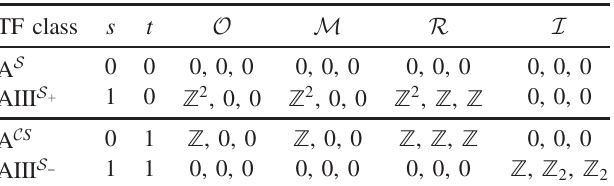
TABLE X. Boundary classification of third-order phases in three-dimensional systems with an order-two symmetry (anti- symmetry) for complex tenfold-way classes. The symbols O , M , R , and I refer to a local on-site ( d ¼ 0 ), mirror ( d ¼ 1 ), k k twofold rotation ( d ¼ 2 ), and inversion symmetry ( d ¼ 3 ), k k respectively. The boundary classification groups are given in